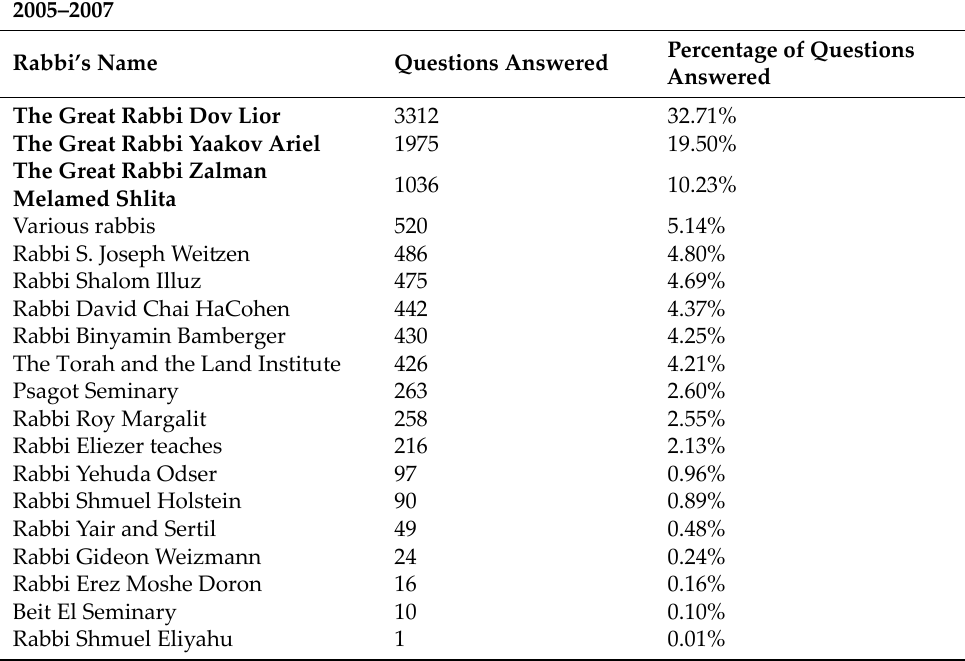
Table A1. Rabbis Who Answered Questions in the Early Years of the Website. The Website Gives the Title “the Great” to Rabbis Who Are Institutionally Recognized and Well‑Known. The three rabbis who dominated the website’s answers in the earlier years of its activity are in bold.